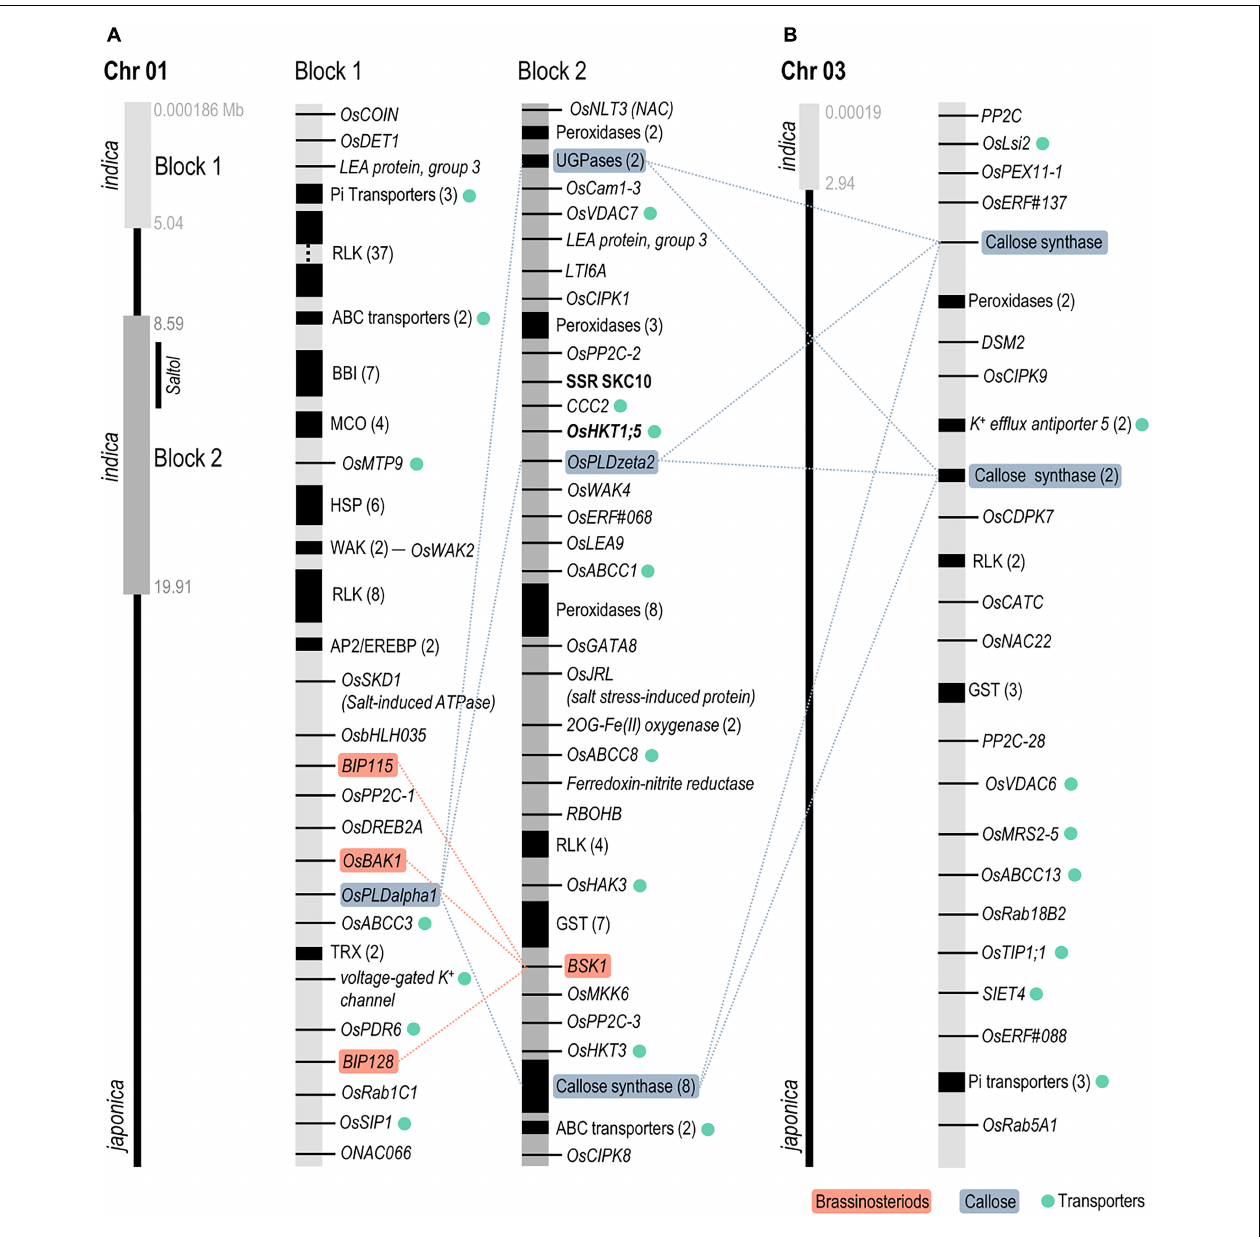
FIGURE 4 | Scheme of indica introgressions identified in Chromosome 1 ( A , Block 1 and Block 2) and Chromosome 3 (B) of IL22 plants. Black regions denote clusters of genes (the number of genes in each cluster is shown in parenthesis). 2OG-Fe(II) (2-oxoglutarate Iron 2), ABC ( ATP Binding Cassette transporters ), AP2/EREBP ( APETALA2/ethylene-responsive element binding protein TF), BAK [ Brassinosteroid Insensitive 1 (BRI1)-associated receptor kinase ] , BBI ( Bowman–Birk proteinase Inhibitor ), bHLH ( Basic helix–loop–helix TF), BIP [ Brassinosteroid receptor kinase (BRI1)-interacting protein ], BSK1 ( BR-signaling kinase 1), Cam ( Calmodulin ), CATC ( Catalase C ), CCC2 ( Cation-Chloride cotransporter 2 ), CDPK7 ( Calcium-dependent protein kinase 7 ), CIPK ( Calcineurin B-like interacting protein kinase ), COIN ( Cold inducible ), DET1 ( De-Etiolated 1 ), DREB2A ( Dehydration responsive element binding 2A ), DSM2 ( drought-sensitive mutant 2 ), ERF ( Ethylene Responsive Factor TF), GST ( Glutathione-S-transferase ), HAK (High-affinity Potassium Transporter ), HKT ( High-affinity Potassium Transporter ), HSP ( Heat Shock Protein ), JRL ( jacalin-related mannose-binding lectin ), LEA ( Late Embryogenesis Abundant protein ), Lsi2 ( Low Silicon 2 ), LTI6A ( Low temperature-induced 6A ), MCO ( Multicopper Oxidase ), MKK6 [ mitogen activated protein kinase (MAPK) kinase 6 ], MRS2-5 ( Mitochondrial RNA Splicing, Mg 2 + transporter 2-5 ), MTP9 ( Metal Tolerance Protein 9 ), NAC ( NAM/ATAF/CUC TF), PDR6 (Pleiotropic Drug Resistance 6), PEX11-1 ( Peroxin 11-1 ), PLD ( Phospholipase D ), PP2C ( Protein Phosphatase 2C ), Rab (Ras-related in brain ), RBOHB ( Respiratory burst oxidase homolog B ), RLK ( Receptor-Like Kinase ), SIET4 ( Silicon efflux transporter 4 ), SIP1 ( Small and basic intrinsic protein 1 ) , SKCD1 ( Suppressor of K + transport growth defect-like protein 1 ), TIP1;1 ( Tonoplast intrinsic protein 1;1 ), TRX ( Thioredoxin ), UGPases ( UDP-glucose pyrophosphorylases ), VDAC (voltage-dependent anion cannel ), and WAK ( Wall-Associated kinase ).